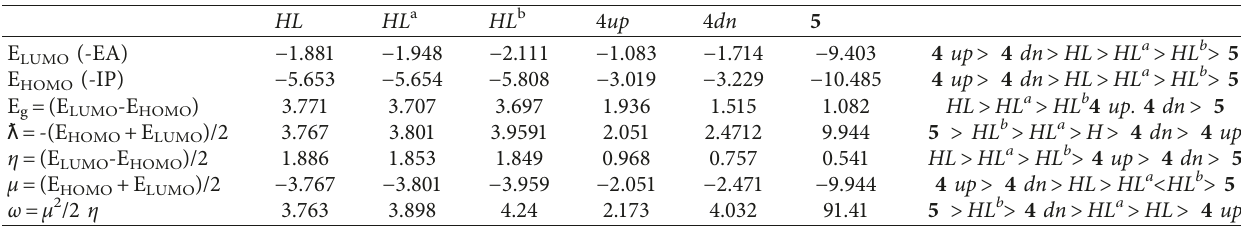
Table 8: Global chemical reactivity indices (eV), and the biological activities of studied compounds and relationship between them. The biological activities (ID 50 ) were taken from Tables 3, 6, and 7. EA–and IP are the electron affinity and ionization potential,